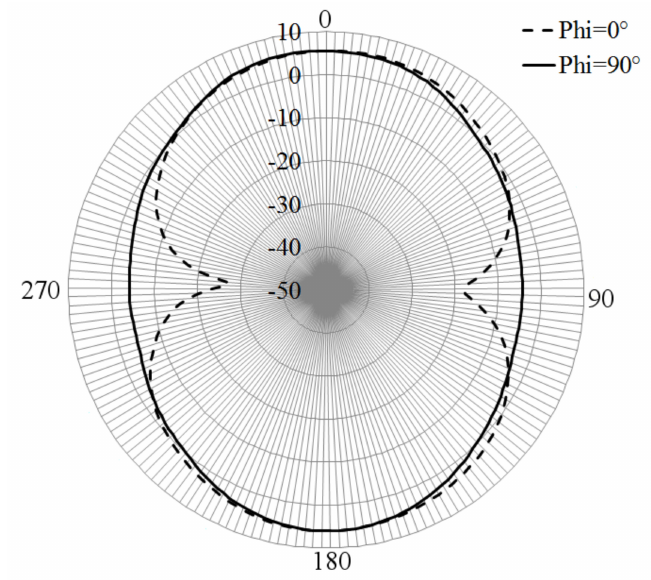
Figure 4. Simulated gain pattern of dumbbell-shaped slot.